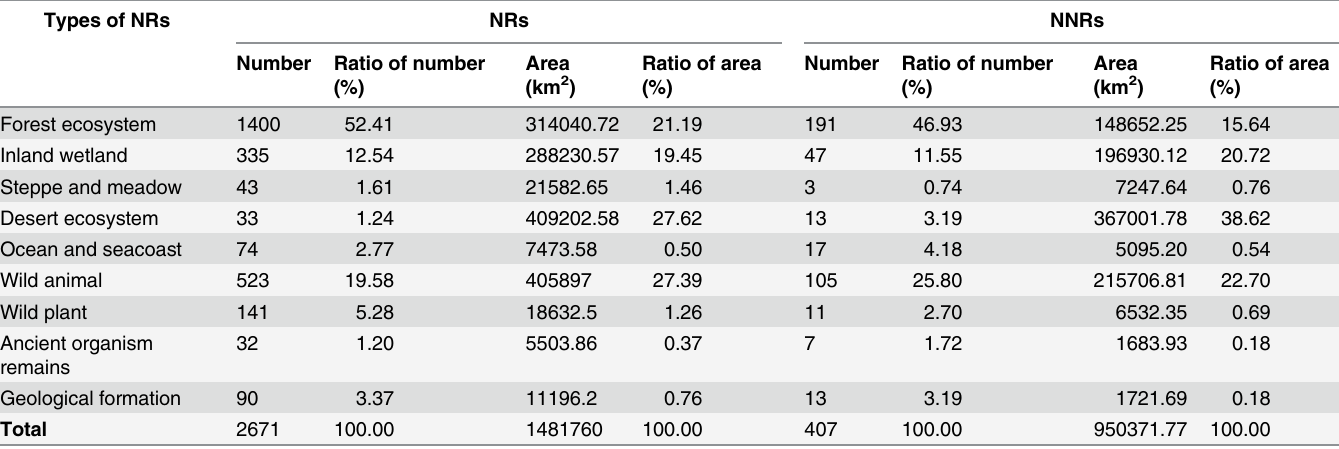
Table 3. Statistics for NR and NNR types in mainland